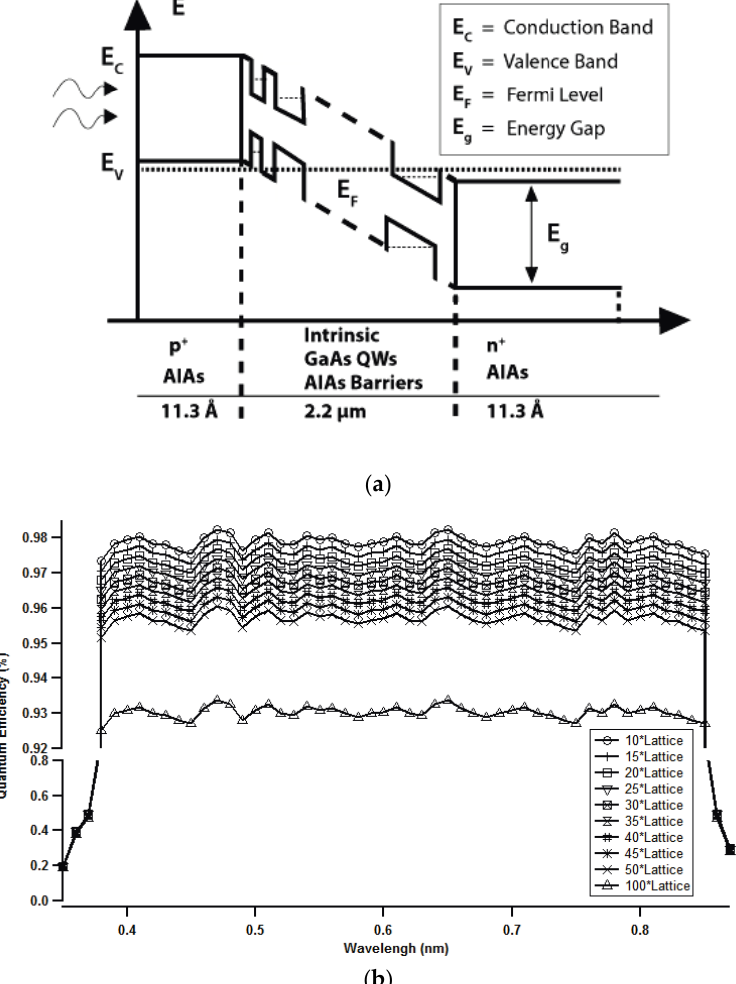
Figure 5. This is a figure data presented from [65] with the permission of AIP Publishing: ( a ) Energy diagram of a heterojunction solar cell with p – i – n QW; ( b ) QW efficiency versus wavelength for all 10 sets of QWs.